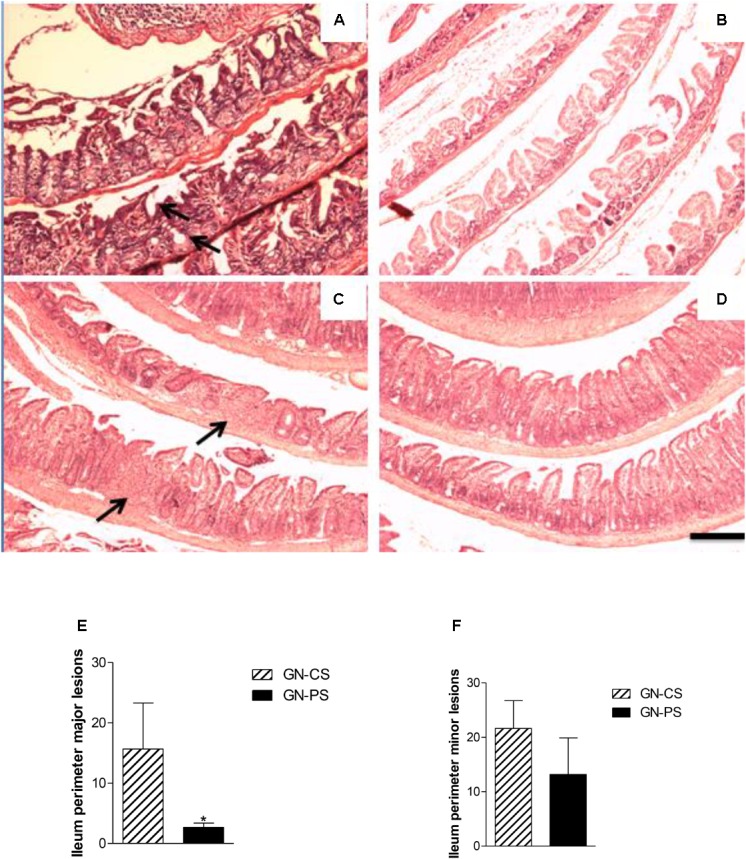
Histopathological aspect of ileum from mice monoassociated with L. diolivorans 1Z (GN-PS) or not (GN-CS) and challenged with S. Typhimurium. (A) GN-CS 2d, and (B) GN-PS 2d, animals sacrificed after 2 days of infection; (C) GN-CS 8d and (D) GN-PS 8d, animals sacrificed after 8 days of infection. Arrows indicate areas of villus damage with discreet increase of the cellularity of the lamina propria in panel (A) and inflammatory infiltrate focus in panel (C). H&E, scale bar represents 100 μm. Perimeter of minor (E) and major (F) lesions attributed to Salmonella infection in ileum of mice monoassociated (GN-PS) or not (GN-CS) with L. diolivorans 1Z and challenged with S. Typhimurium. The samples were taken at day 8 postinfection. The symbol “∗” indicates statistical difference between the groups GN-CS and GN-PS (ANOVA followed by Tukey test; P < 0.05).